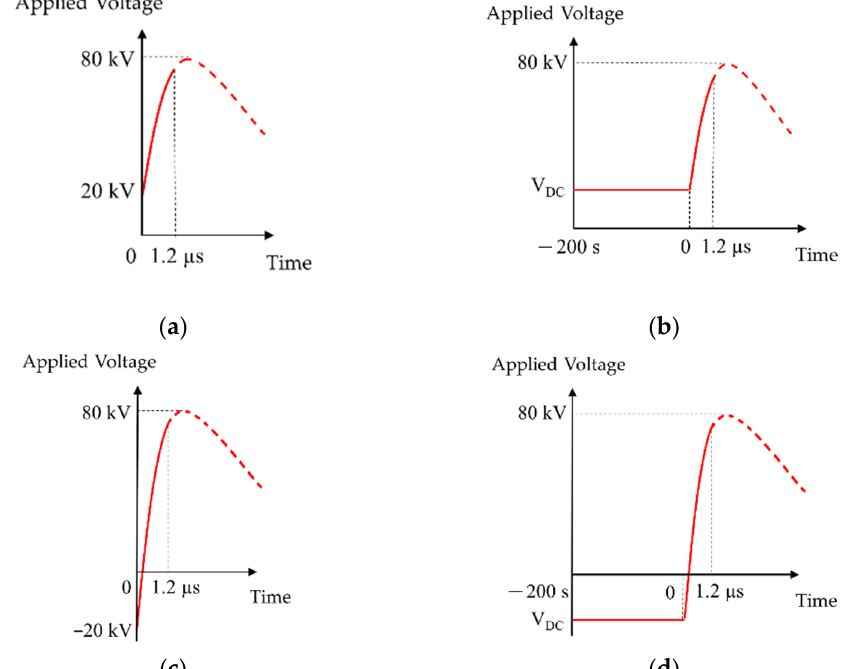
Figure 2. Voltage waveforms used in the simulations: ( a ) 1st case; ( b ) 2nd case; ( c ) 3rd case; ( d ) 4th case.